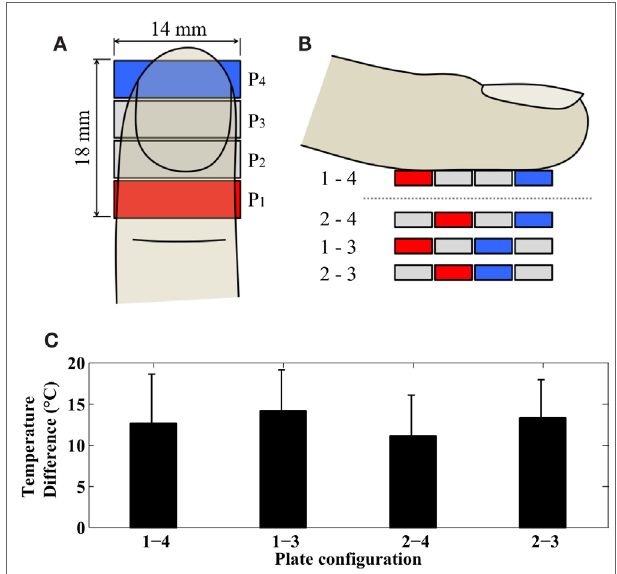
FigUre 5 | representation of the four plates of the display, the blue plate is cold, the red is hot, and the gray plates are set to body temperature . (a) Top view of configuration 1–4. (B) Side view with the four temperature configurations. (c) Just noticeable temperature difference between two simultaneous thermal stimuli. There was no significant effect of plate